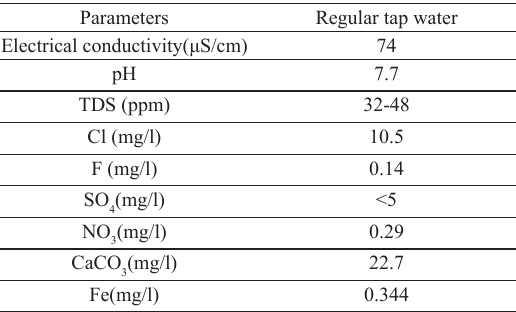
Table 2. Physicochemical analysis of regular tap water